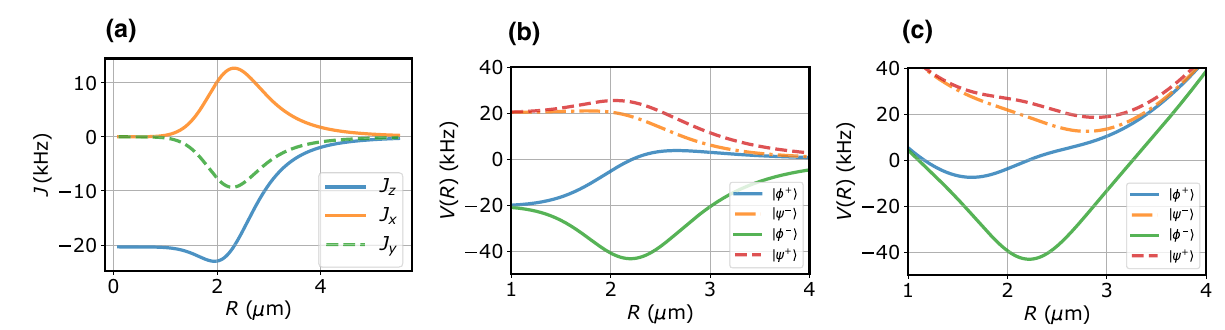
FIG. 11. (a) The alternative spin-pattern profile. (b) The resulting spin-dependent potentials. (c) The resulting spin-dependent potentials after adding the spin-independent harmonic potential.